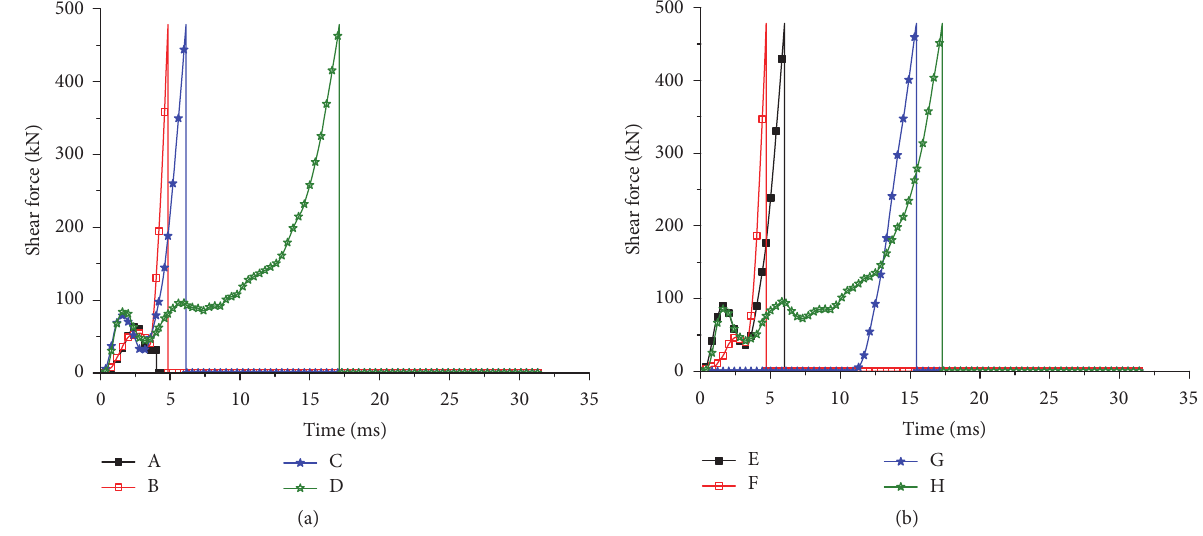
Figure 14: The shear force time history curves for (a) bolts A, B, C, and D and (b) bolts E, F, G, and H in Model